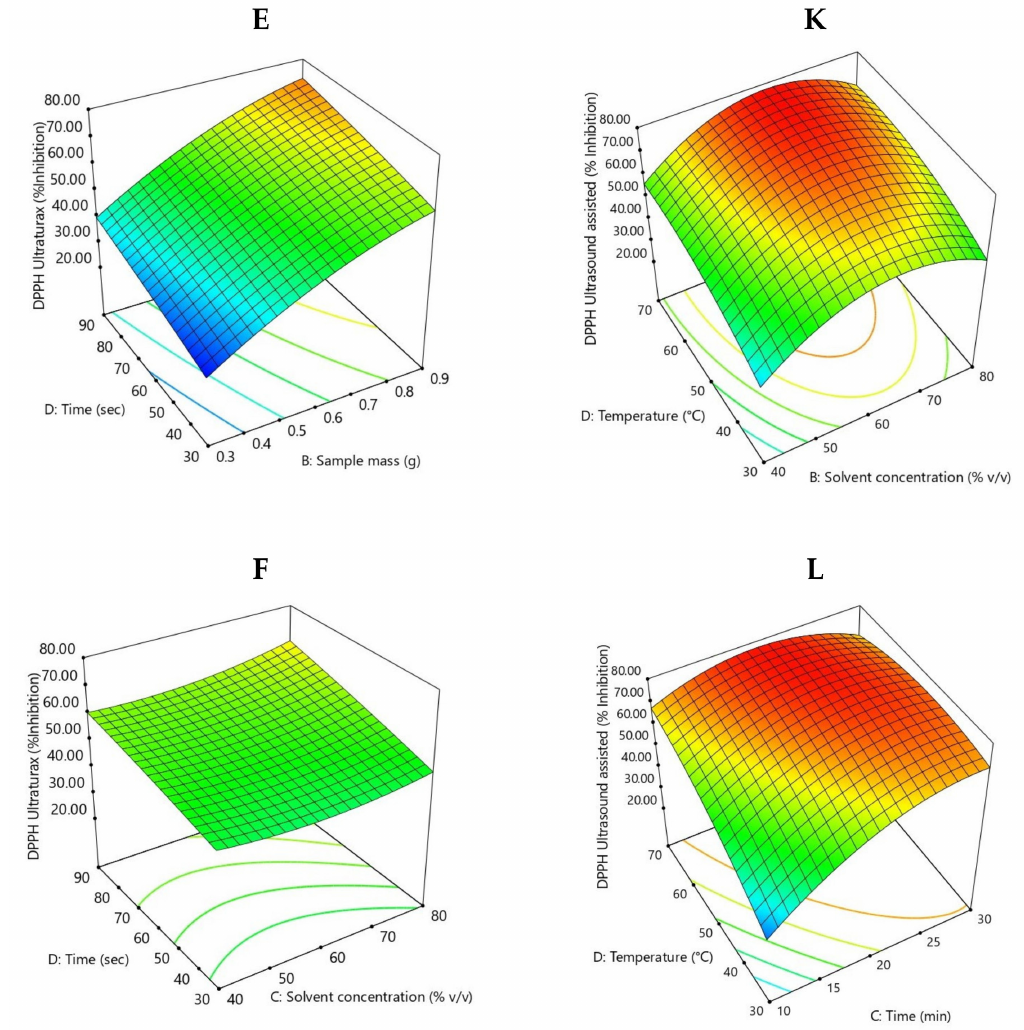
Figure 4. Response surface plots showing the effect of extraction parameters on antioxidant activity for SG Ultra-Turrax pre-treatment ( A – F ), and for ultrasound-assisted pre-treatment ( G – L